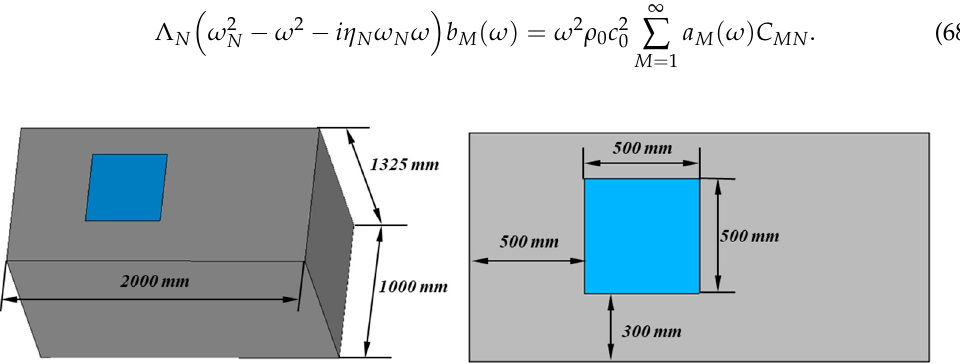
Figure 20. Simplified rectangular cavity model enclosed by a flexible panel.